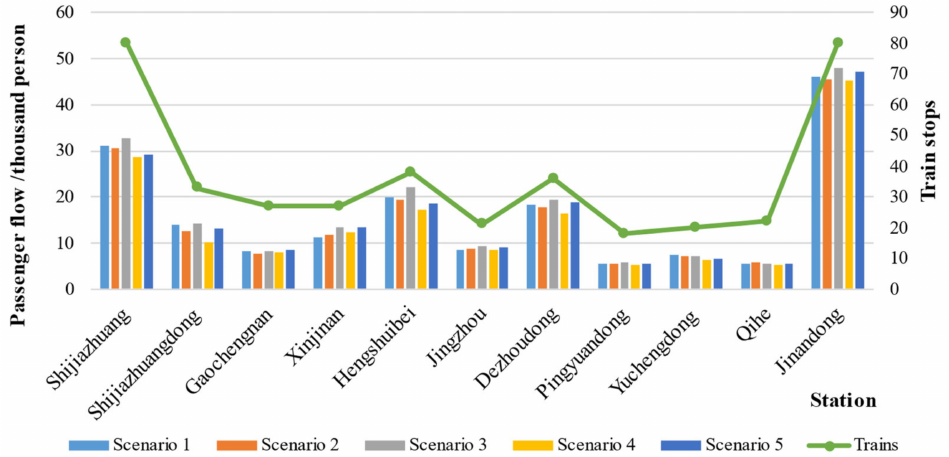
Figure 11. Correspondence between the train stops at each station and passengers getting on and off.